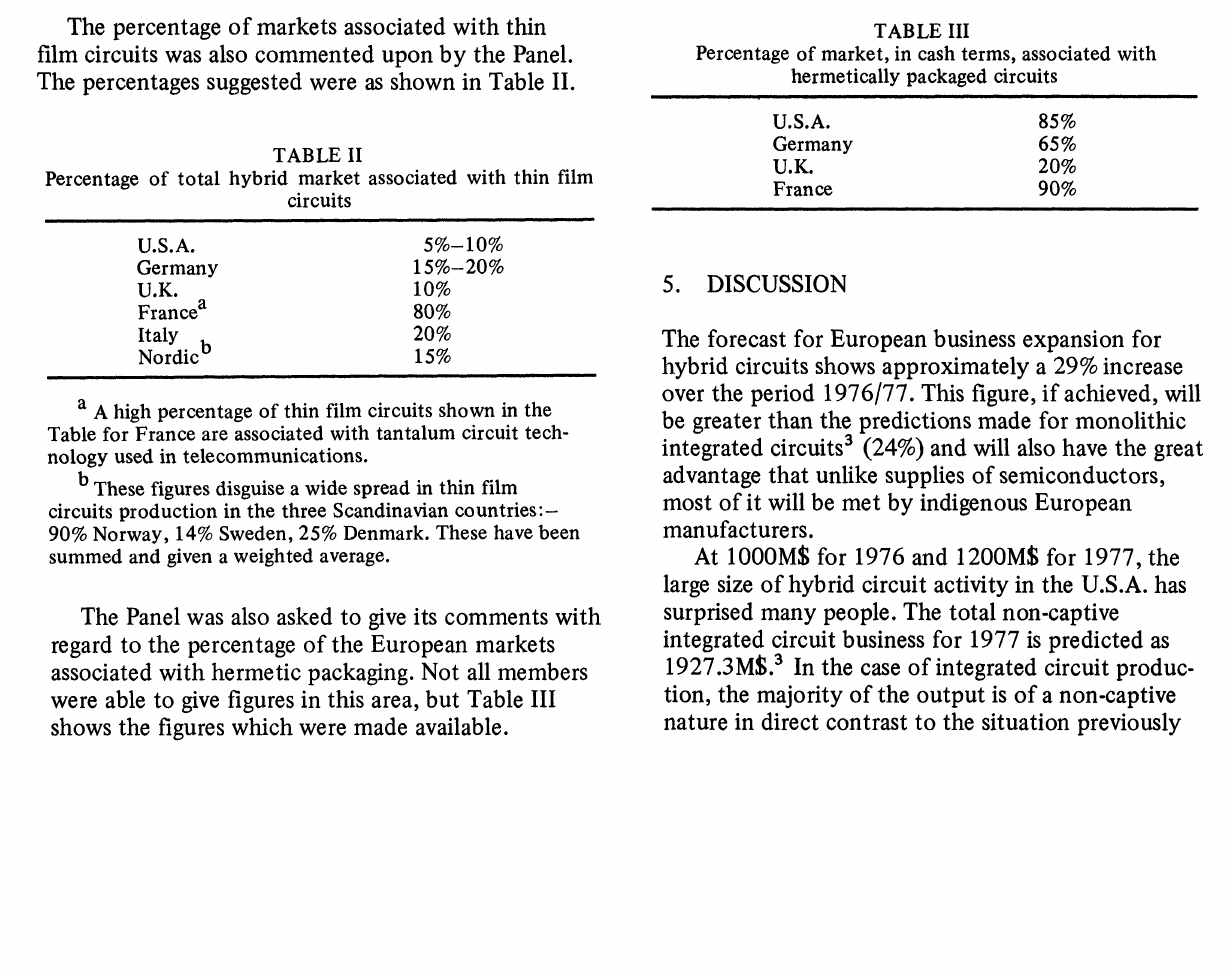
TABLE III Percentage of market, in cash terms, associated